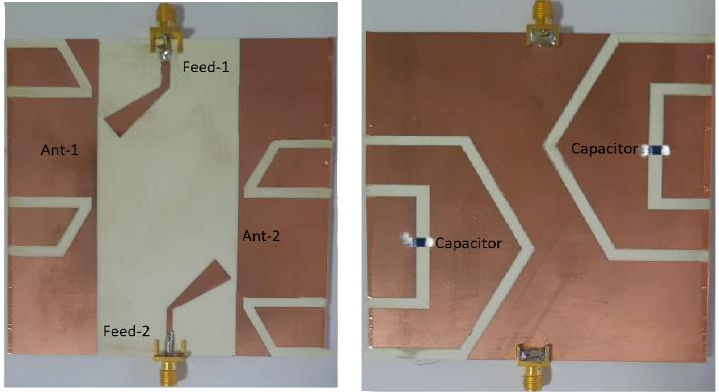
Figure 3. Fabricated prototype of the proposed CubeSat MIMO antenna: ( a ) top view and ( b ) bottom view.